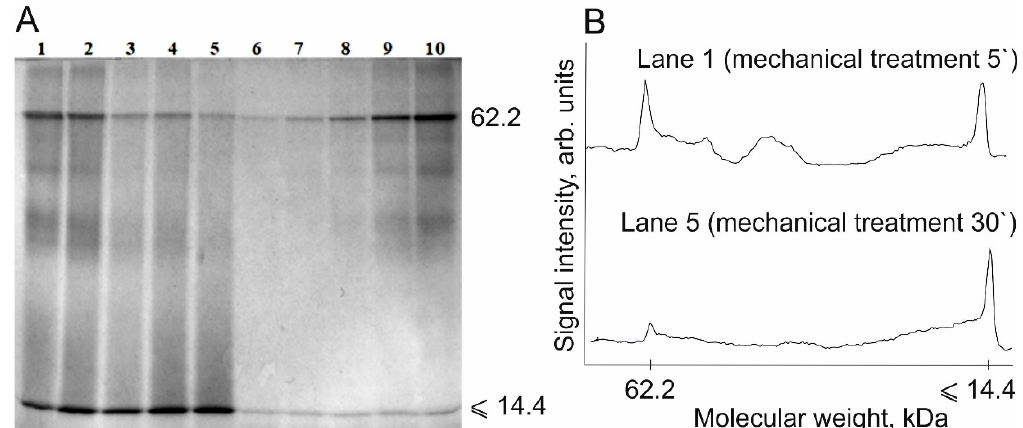
Figure 5. ( А ) Electropherogram of the BSA degradation products after mechanical treatment for 5, 10, 15, 20, and 30 min (lanes 1–5) and the calibration BSA samples with concentration ranging from 0.0125 to 0.2 mg/mL (lanes 6–10); volume of the applied sample = 10 µL. ( B ) Densitograms of the BSA degradation products after mechanical treatment for 5 and 30 min (lanes 1 and 5).